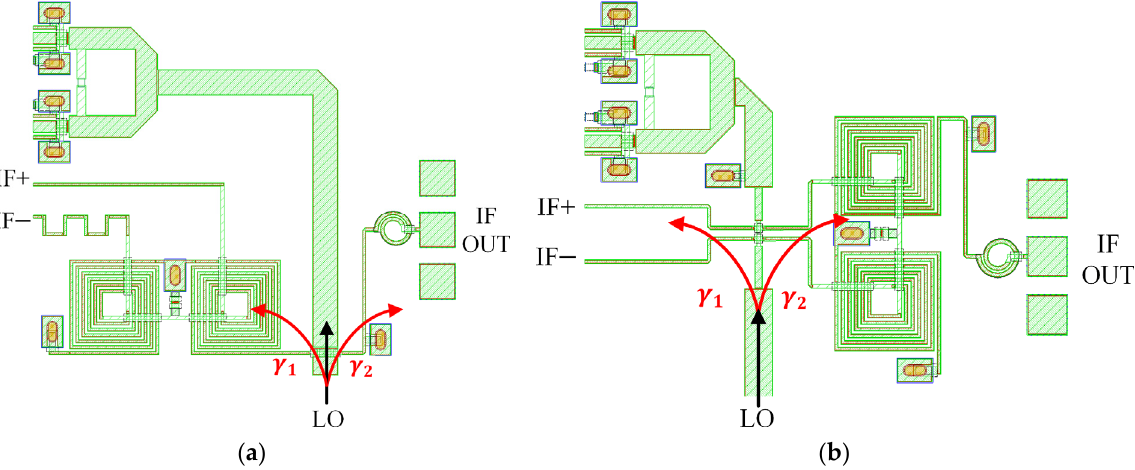
Figure 16. ( a ) The LO is directly crossed over the IF transmission line. ( b ) The LO is crossed over the IF differential lines.